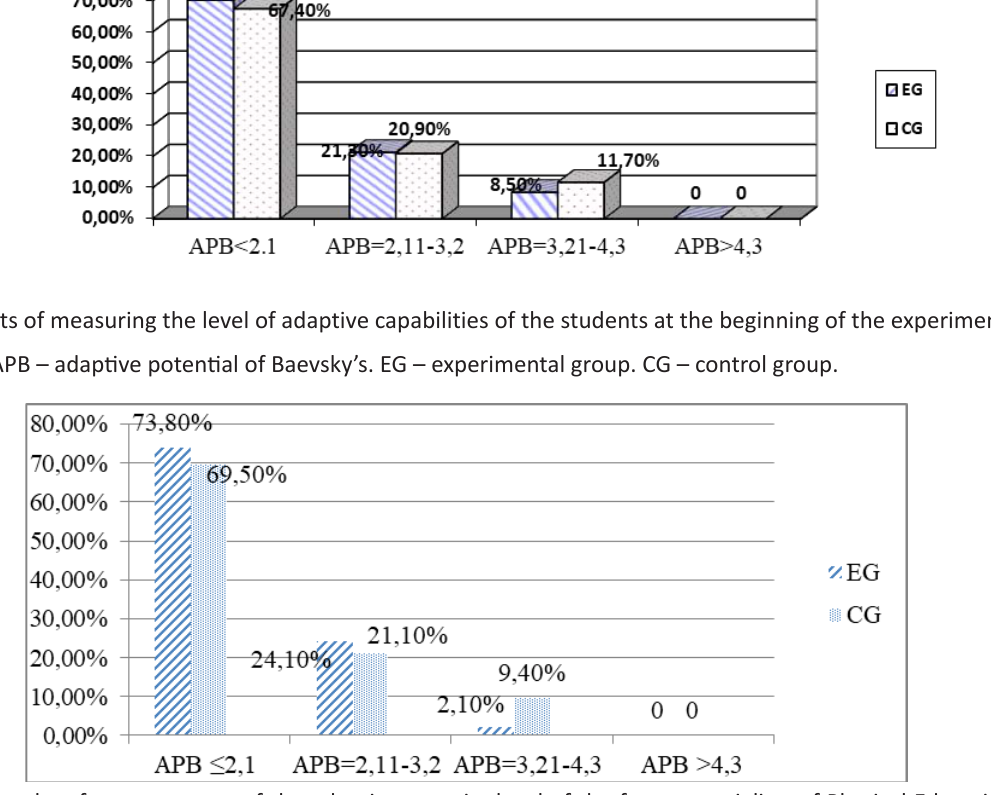
Fig. 2. The results of measurement of the adaptive capacity level of the future specialists of Physical Education and Sports after the experiment,